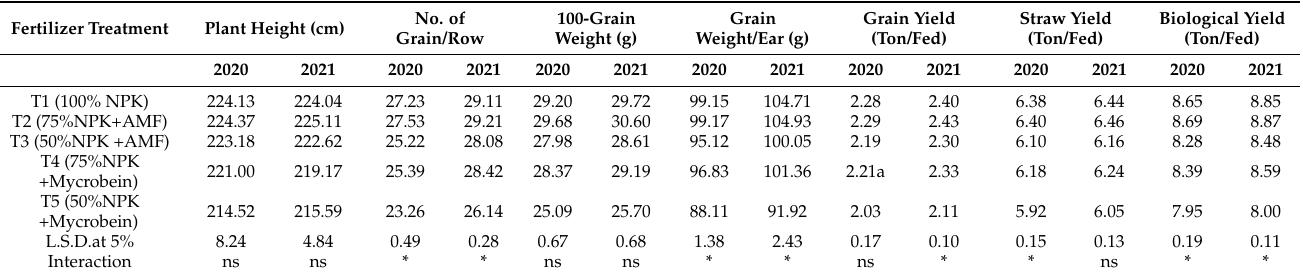
Table 5. The effect of fertilizer treatments on maize yield and some of its components under inter- cropping system during 2020 and 2021